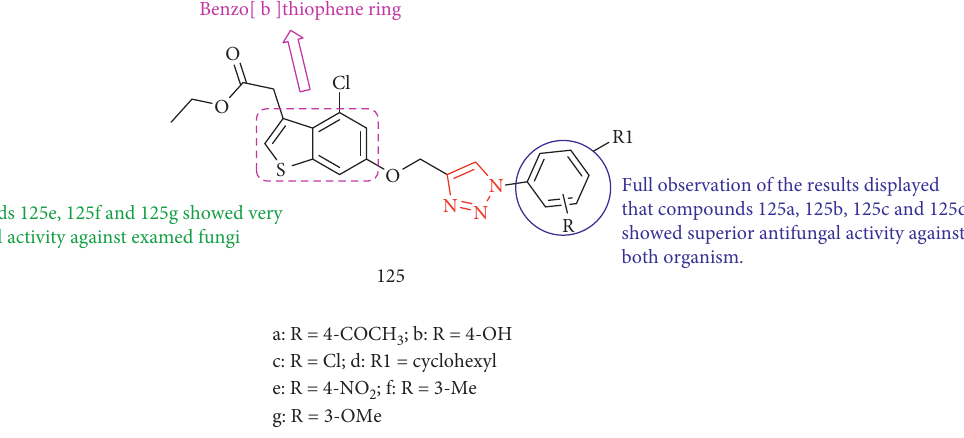
Figure 60: Chemical structure of benzo[b]thiophenes-1,2,3-triazole derivatives.